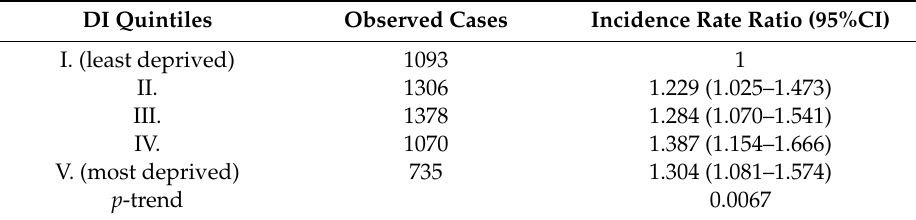
Table 1. Mortality risk due to thromboembolic diseases for 40–X age group of the population at the district level by deprivation index (DI) quintiles, Hungary, 2016.